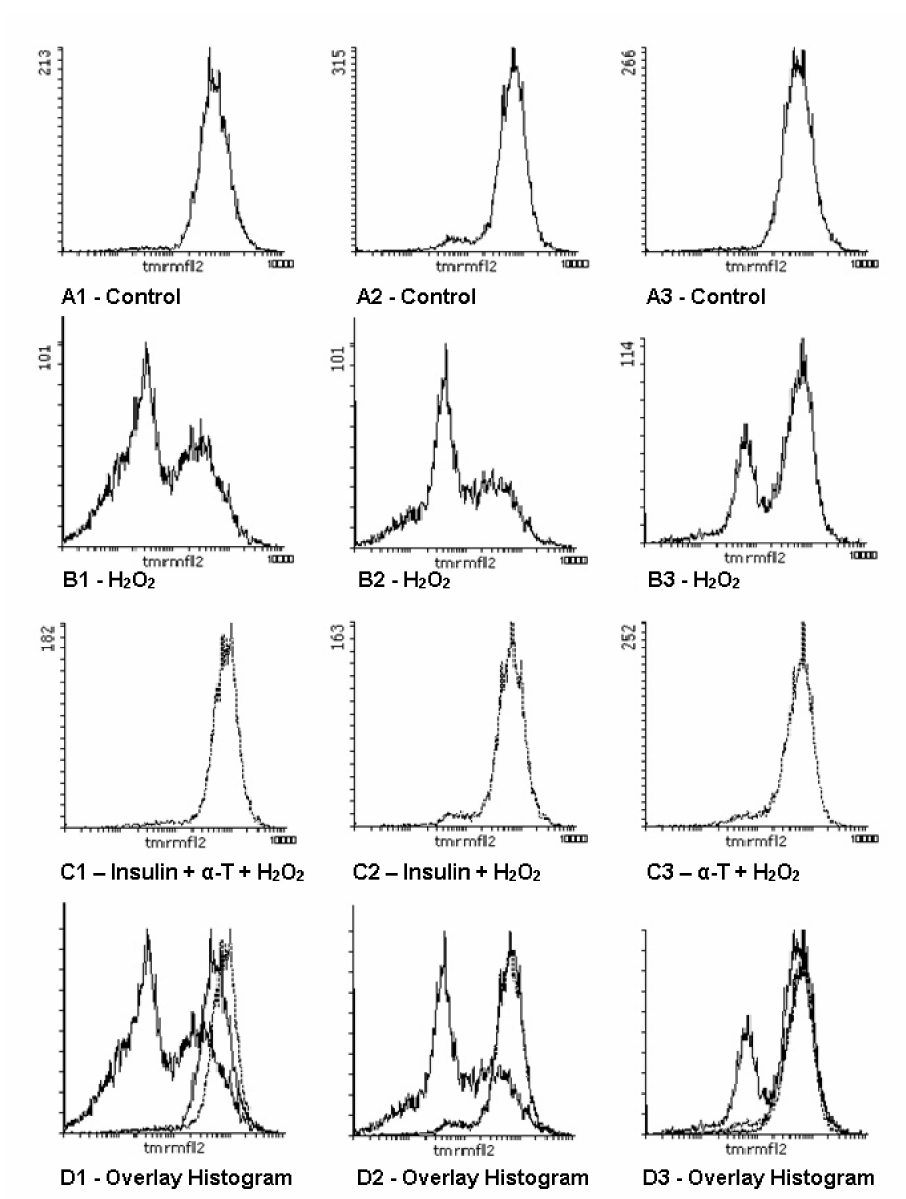
Figure 7. The effect of hydrogen peroxide, insulin, α -T and insulin plus α -T on the mitochondrial membrane potential in cortical neurons (histograms obtained by flow cytometry). Cortical neurons were pre-incubated with 1 µ M insulin, 50 µ M α -T or with both compounds. Then neurons were exposed to 100 µ M hydrogen peroxide for 1 h. A1, A2, A3—controls, B1, B2, B3—the effect of hydrogen peroxide alone, C1, C2, C3—the effect of hydrogen peroxide after pre-incubation of neurons with: C1—1 µ M insulin and 50 µ M α -T, C2—1 µ M insulin, C3—50 µ M α -T, D1, D2, D3—the overlay of the histograms presented in A, B and